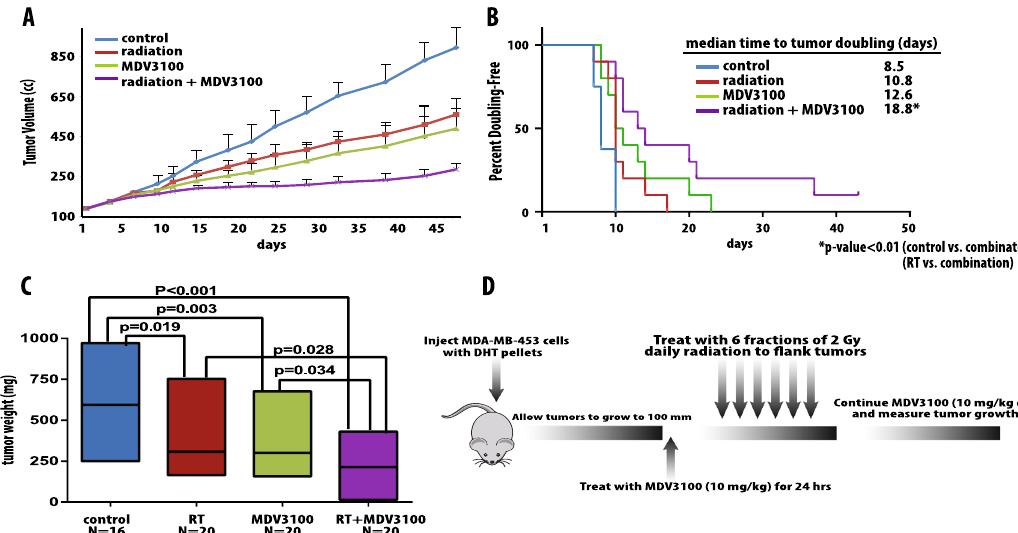
Fig. 4 AR inhibition through with MDV3100 signi fi cantly radiosensitized TNBC xenografts with AR expression in mouse models and markedly delayed tumor doubling time and tumor weight. CB17-SCID mice were injected with 1 × 10 6 MDA-MB-453 cells and tumors were allowed to grow to ~100 mm 3 . Treatment was then initiated as depicted in the four treatment groups (control, RT alone, MDV3100 alone, and RT + MDV3100). Tumor volume and weight were tracked, and time to tumor doubling was plotted ( a – c ). A schema of treatment is included ( d